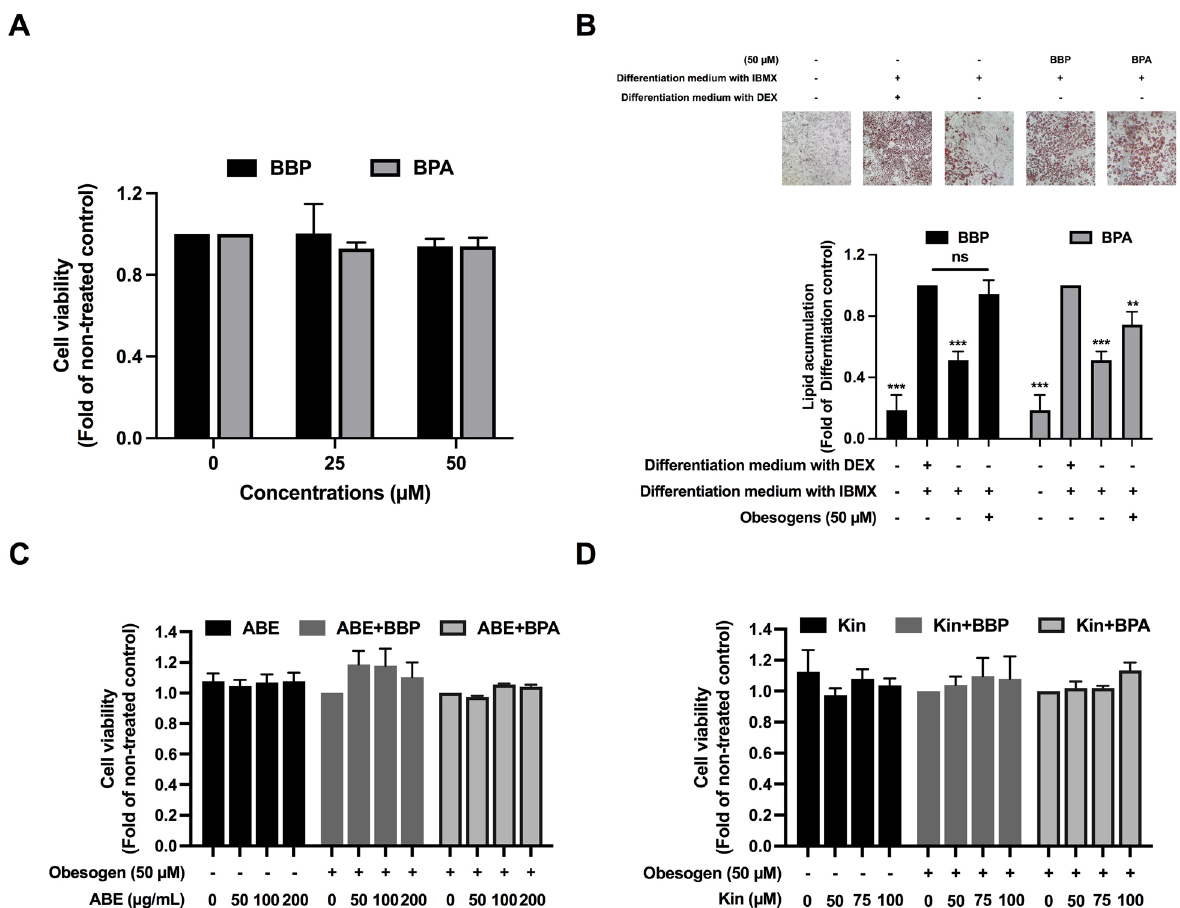
Figure 1. Cytotoxicity of BBP and BPA on 3T3-L1 adipocyte during adipocyte differentiation tested by SRB assay ( A ), BBP and BPA induced lipid accumulation in adipocyte ( B ). Lipid droplet staining using Oil red O dye and the level of lipid accumulation obtained by spectrophotometry of the dye dissolved, Cytotoxicity of ABE ( C ) and Kin ( D ) in the absence or presence of BBP or BPA investigated by SRB assay. The data indicated as mean ± SD of three independent experiments ** p < 0.01 and *** p < 0.001, compared to differentiation control ( B